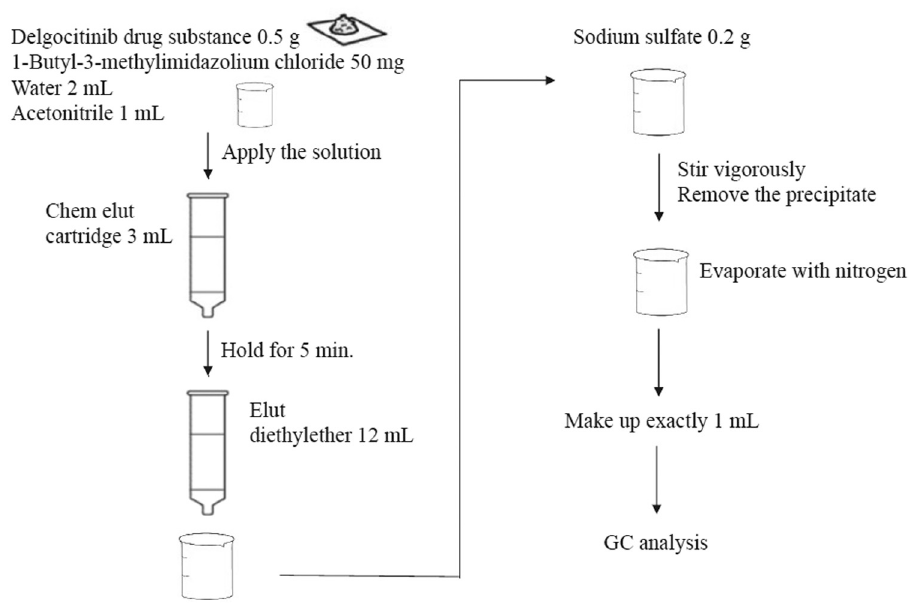
Figure 1: Preparation scheme of the sample